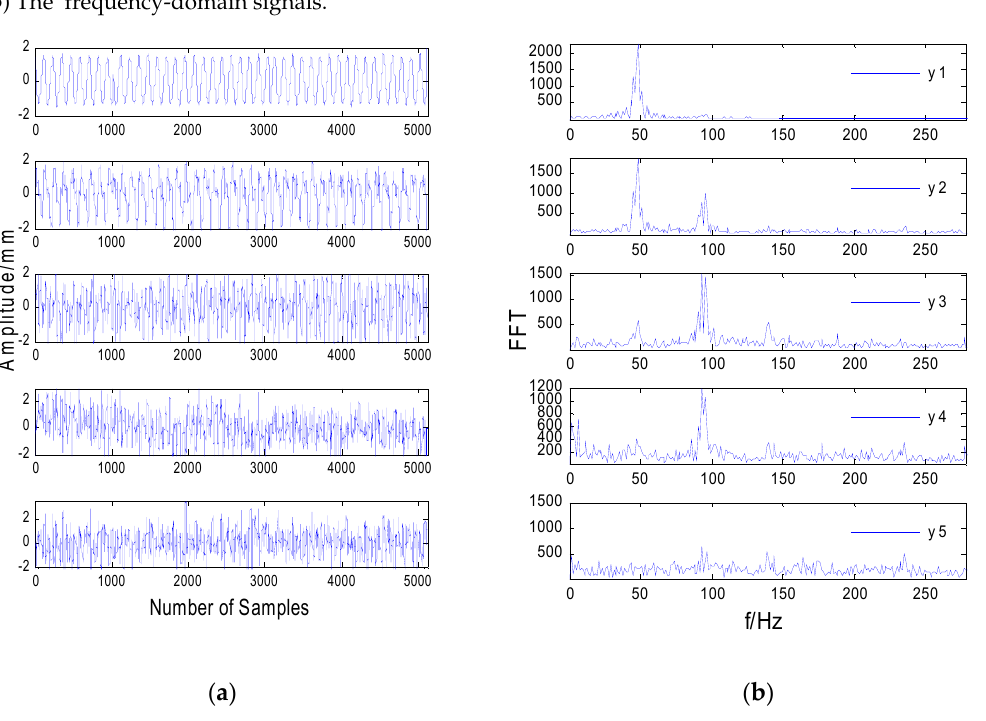
Figure 6. The separated signals by the JADE method. ( a ) The time-domain signals. ( b ) The frequency-domain signals.